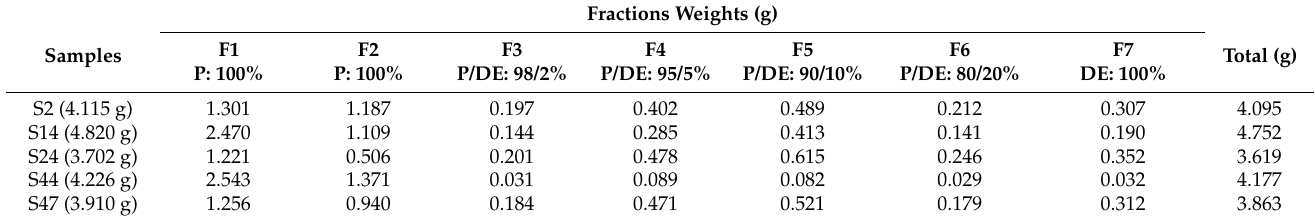
Table 4. Weights of fractions from column